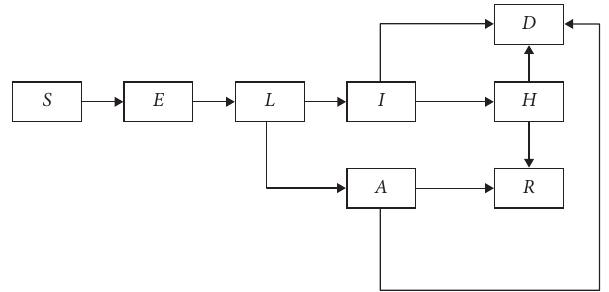
Figure 1: SELAIHRD